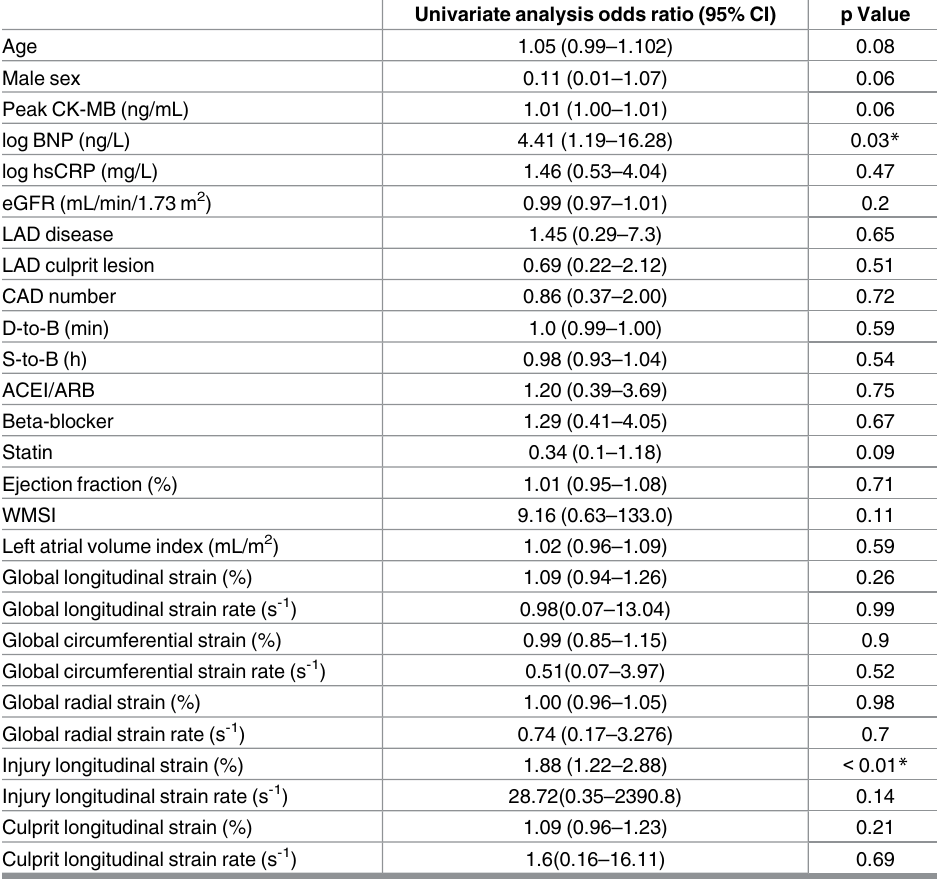
Table 8. Univariate logistic regression for left ventricular remodeling in STEMI